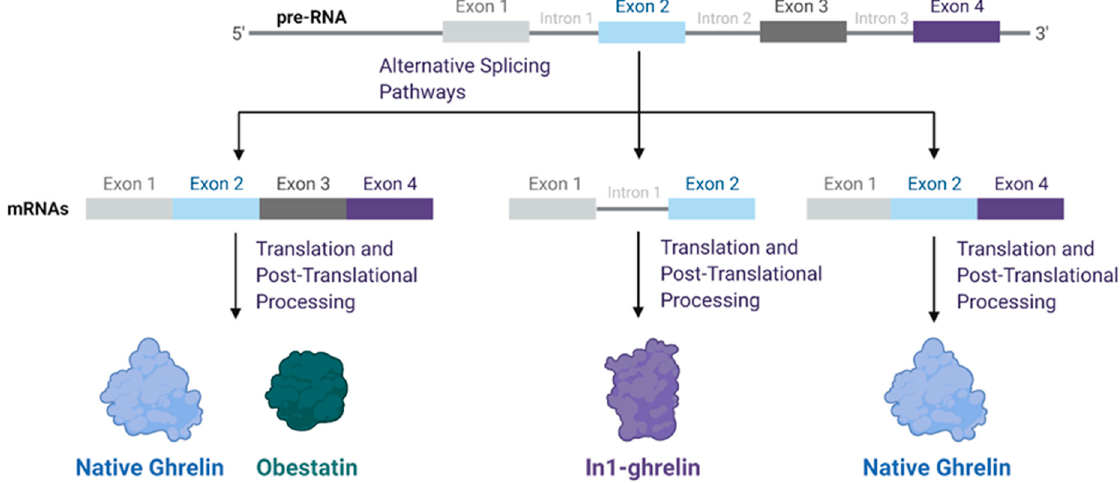
Figure 1. Gene splicing of ghrelin and splice variants. Diagram summarizing the different splicing pathways leading to the generation of the various mRNA transcripts formed from GHRL transcription. Splicing of exons 1–4 yields products of native ghrelin (acylated or unacylated) and obestatin. The inclusion of intron 1 coupled with the exclusion of exons 3–4 leads to the production of the In1-ghrelin variant. Exclusion of exon 3 alone yields the exon-3 deleted preproghrelin transcript, which is further processed to produce native ghrelin.